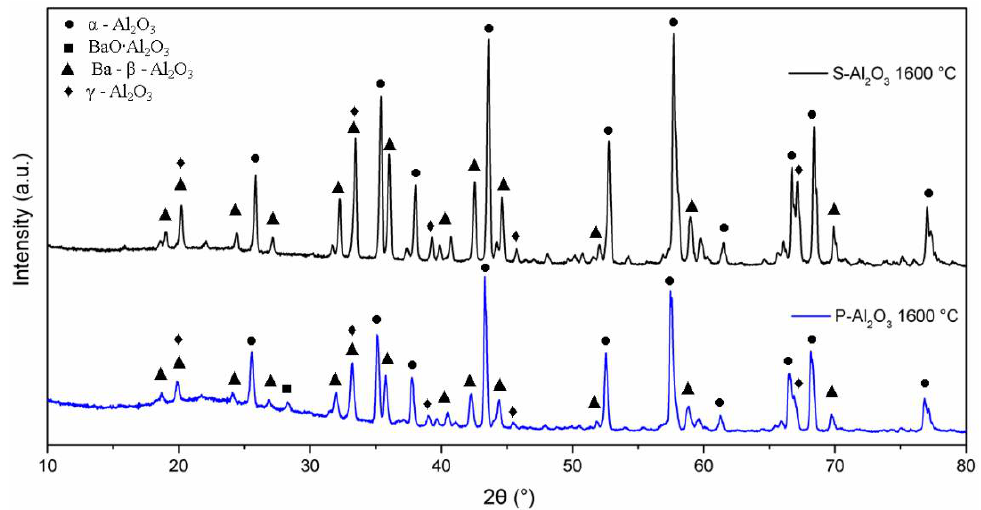
Figure 6. XRD diffractogram of powders and alumina sphere at 1600 °C. Table 1. Phase quantification for powders and alumina sphere.